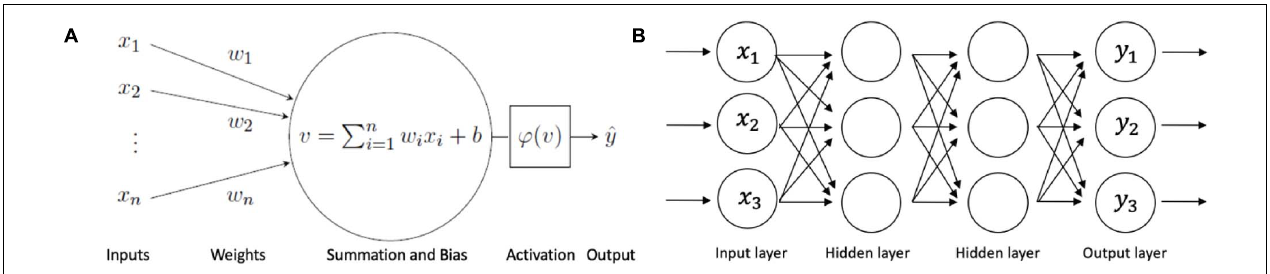
FIGURE 1 | Multilayer perceptron neural network. (A) The perceptron artificial neuron. Input datapoints are represented as x 1 , x n , with synaptic weights w 1 , w n and bias b . The local induced field v is passed through activation function ϕ to generate output ˆ y . (B) Simplified example of a multilayer perceptron neural network.